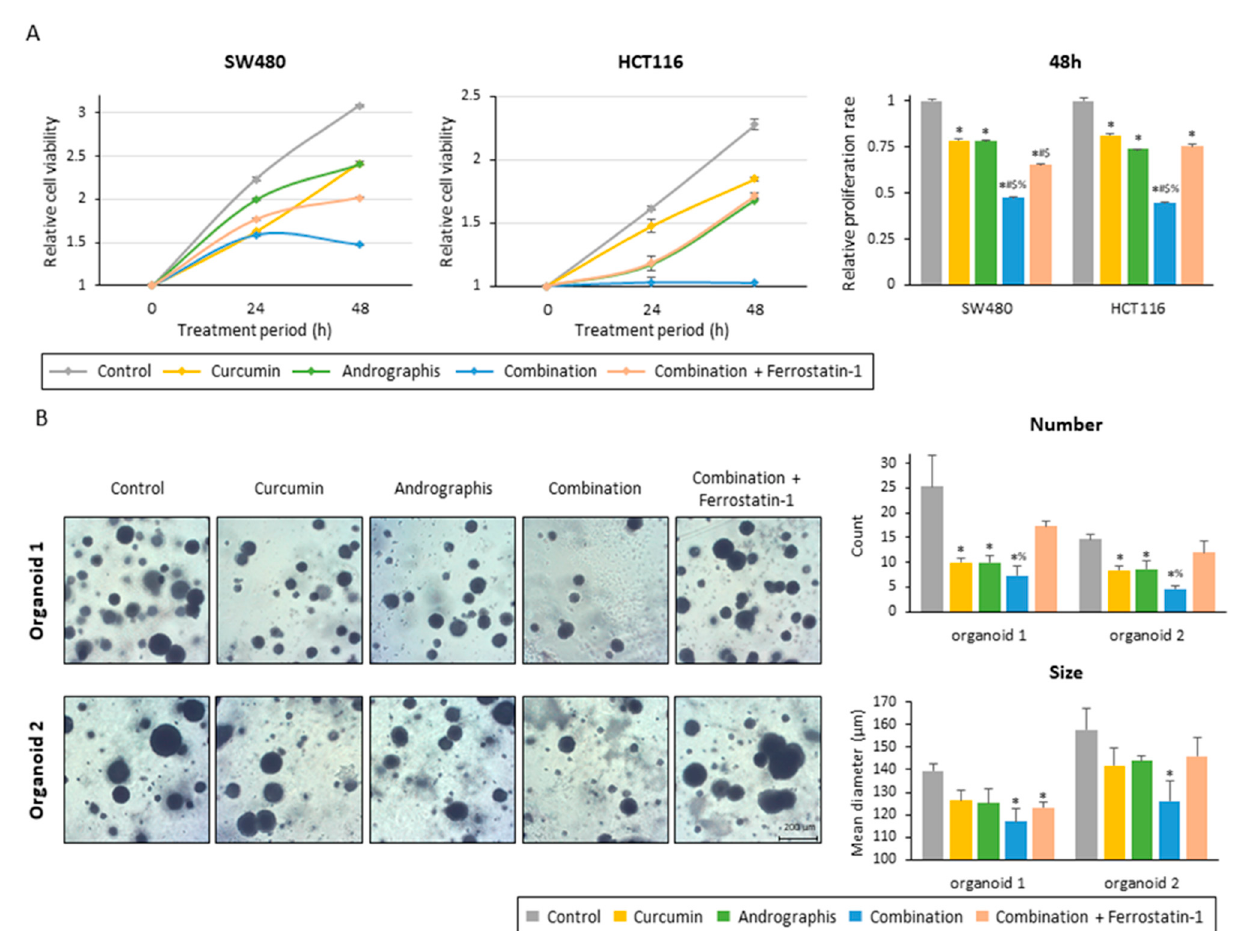
Figure 5. Ferrostatin-1 reversed the anti-tumor effect of the curcumin and andrographis combination. ( A ) Cell proliferation assay in SW480 and HCT116 following treatment with curcumin, andrographis, their combination, and combination plus ferrostatin-1. The error bars represent the mean ± SD. The average (column) ± SD is indicated (*; p -value < 0.05 vs. control, #; p -value < 0.05 vs.